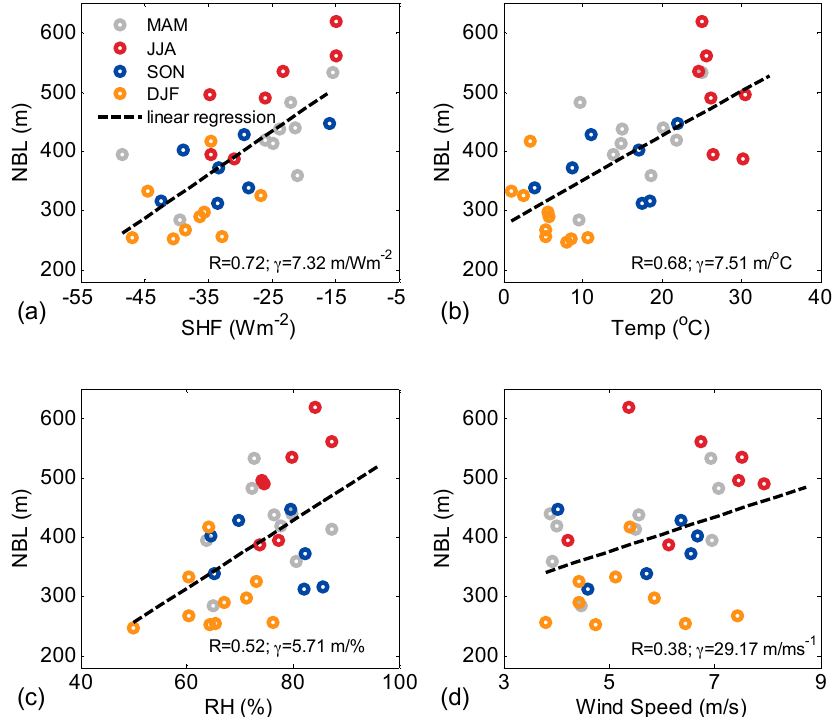
Figure 7. Scatterplots and regression analysis between monthly mean values of NBLH and ( a ) SHF, ( b ) temperature, ( c ) RH and ( d ) wind speed for the entire measurement period. The linear regression (dashed black line) and corresponding correlation coefficient and gradient values ( γ , m/Wm 2 ) are shown in each panel. The colors of the circles correspond to different seasons (color bar in Figure 7a).